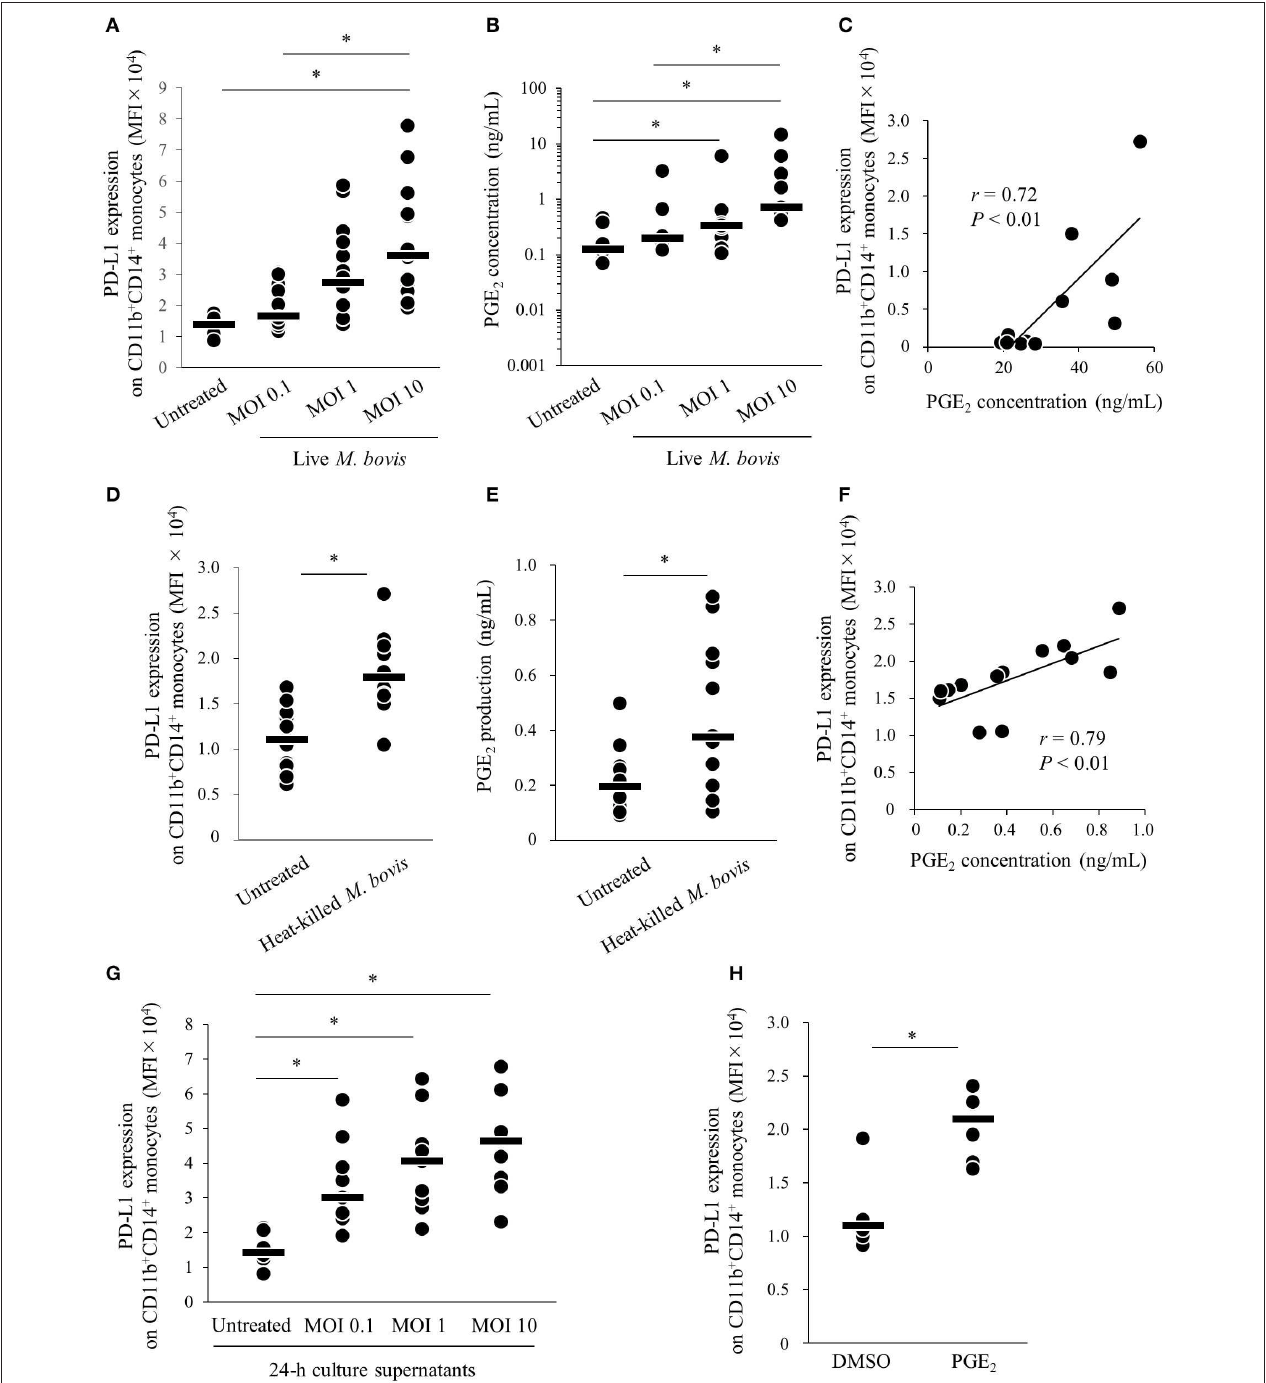
FIGURE 1 | M. bovis upregulates PD-L1 and PGE 2 expression. (A–F) PBMCs from M. bovis -uninfected cattle were incubated with (A–C) live M. bovis (MOI of 0.1, 1, or 10) or (D–F) heat-killed M. bovis (1.5ng/ml) for 24h. (A) PD-L1 expression on CD11b + CD14 + monocytes (untreated: n = 14, MOI 0.1: n = 14, MOI 1: n = 14, MOI 10: n = 14) was determined using flow cytometry. (B) PGE 2 levels in culture supernatants (untreated: n = 9, MOI 0.1: n = 9, MOI 1: n = 9, MOI 10: n = 9) were determined using ELISA. (C) Positive correlation is noted between PD-L1 expression on CD11b + CD14 + monocytes and PGE 2 levels under live M. bovis stimulation (MOI of 10, n = 11). (D) PD-L1 expression on CD11b + CD14 + monocytes (untreated: n = 13, heat-killed M. bovis : n = 13) were determined using flow cytometry. (E) PGE 2 levels in culture supernatants (untreated: n = 13, heat-killed M. bovis : n = 13) were determined using ELISA. (F) Positive correlation is noted between PD-L1 expression on CD11b + CD14 + monocytes and PGE 2 levels under heat-killed M. bovis stimulation ( n = 13). (G) PD-L1 expression on CD11b + CD14 +